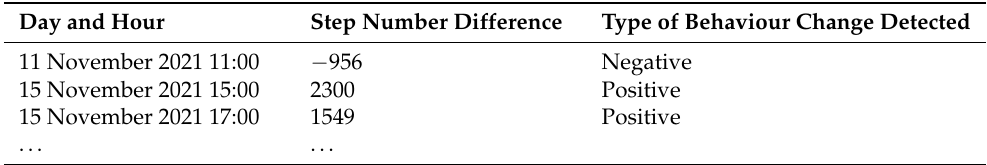
Table 2. Example of data frame with detected behaviour changes.